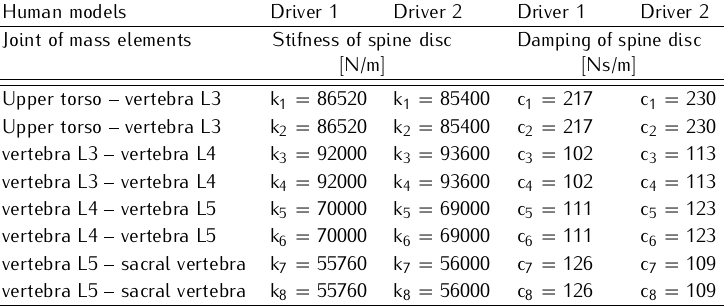
Table 4. Stiffness and damping of spine discs in two models of drivers.